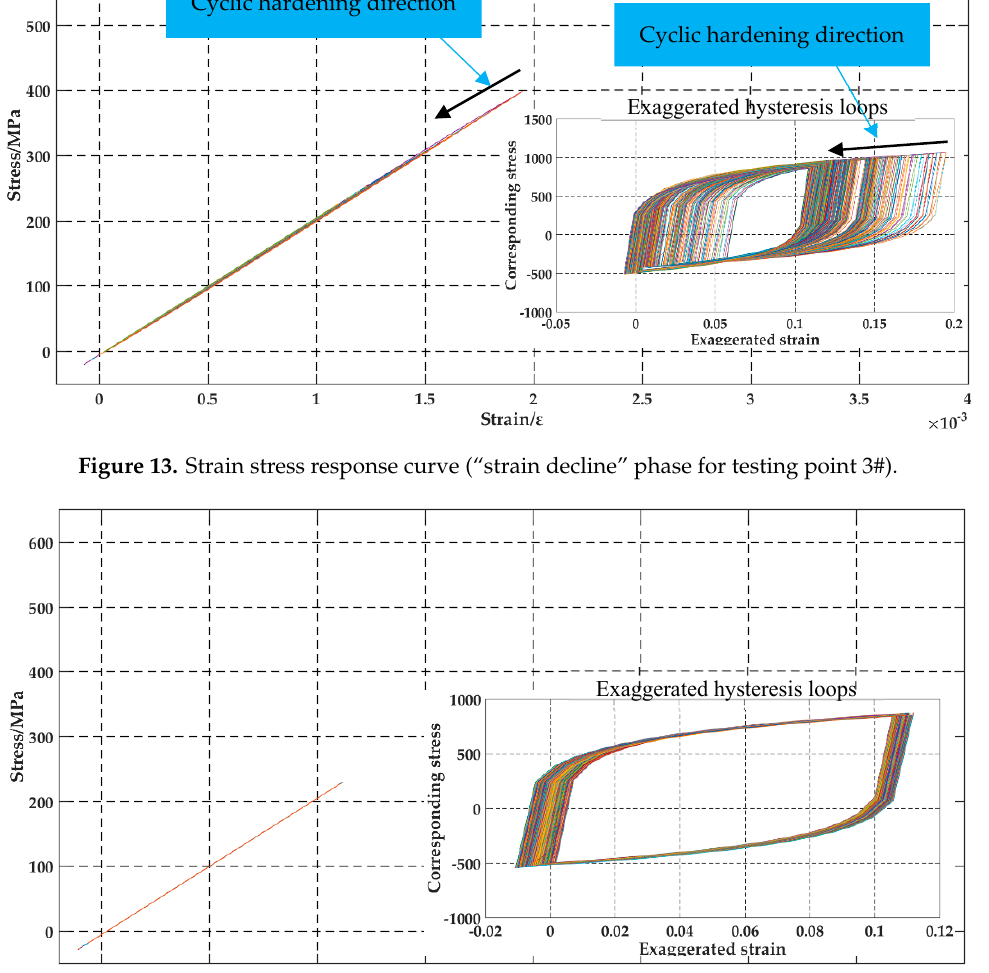
Figure 13. Strain stress response curve ("strain decline" phase for testing point 3#).